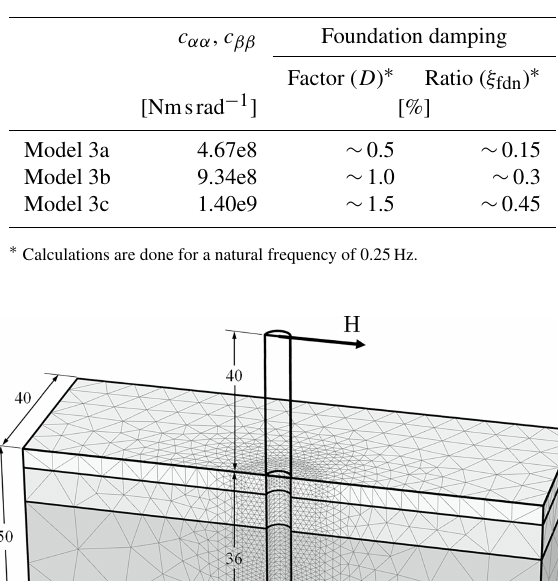
Table 2. Model 3 damping parameters.